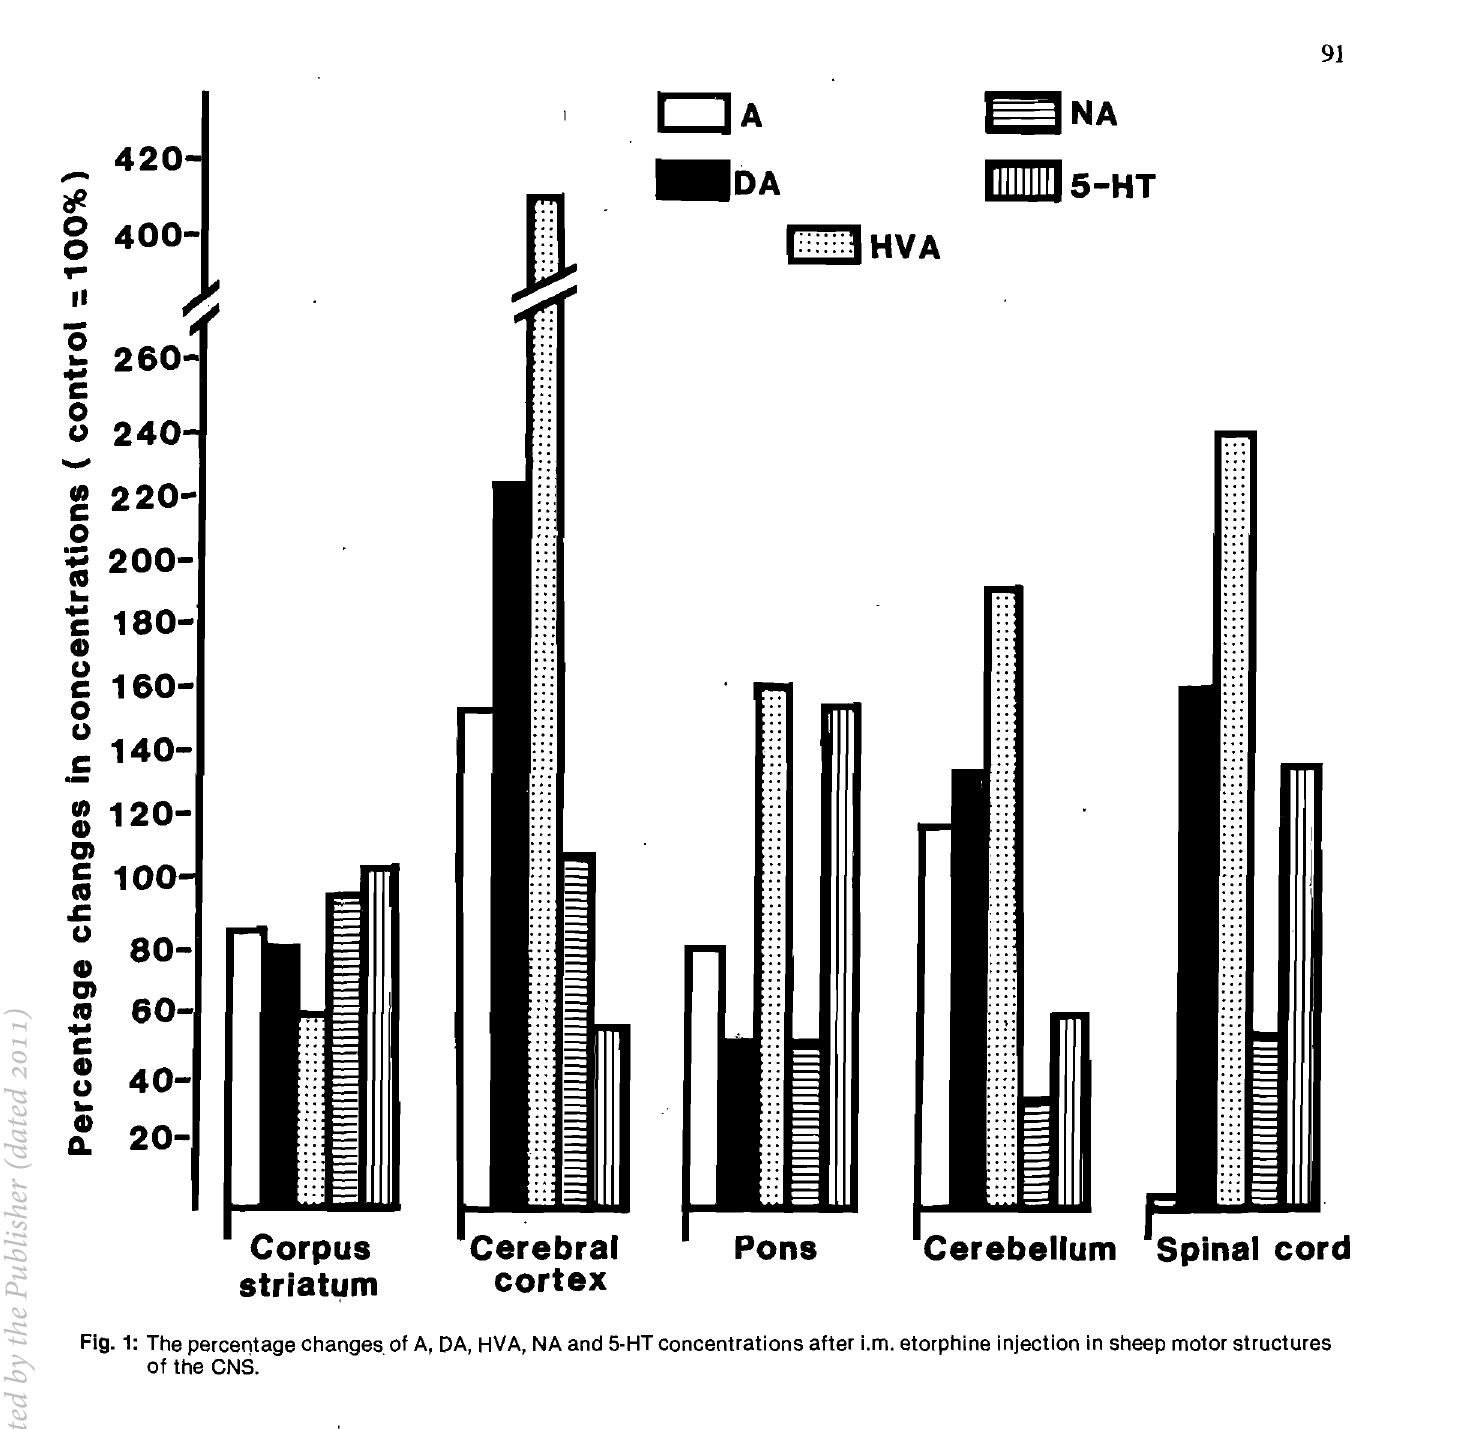
phine inhibition of synthesis of the main mediator of the central structure of the extrapyramidal system, is a stimulating effect of the drug on presynaptic DA receptors. According to Kebabian et al.2 2 stimulation of these receptors leads to inhibition of tyrosine hydrox ylase activity - an enzyme responsible for the transfor mation of tyrosine to dihydroxy-phenyl-alanine (DOP A) which is the direct precursor of